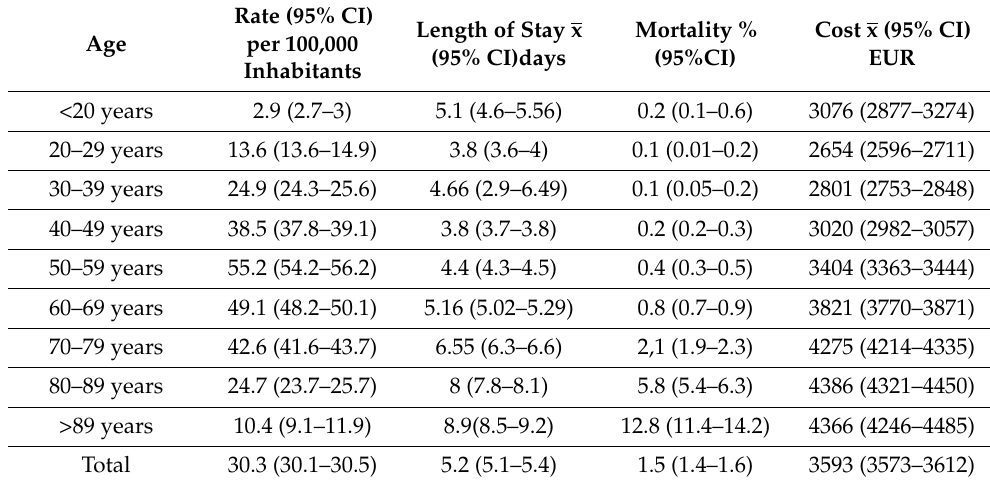
Table 2. Hospitalization rates (rate per 100,000 inhabitants), length of stay (days), mortality (%), and costs (EUR) for kidney stones in Spain (2017–2020) by age.